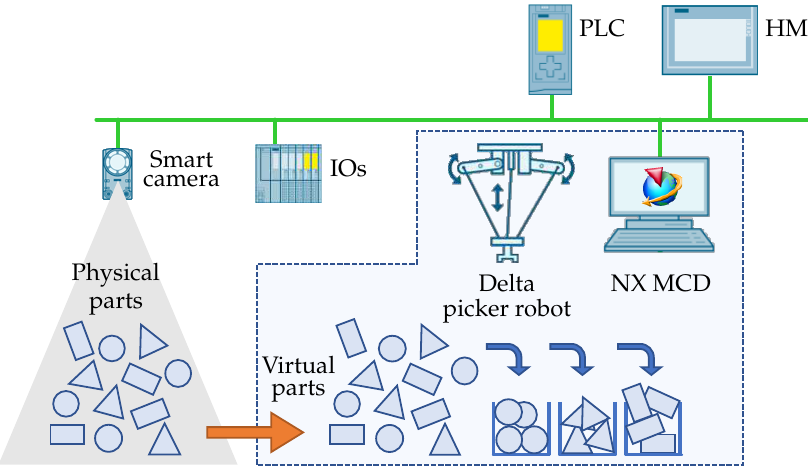
Figure 5. Conceptual design of the delta robot workplace used in our case study.